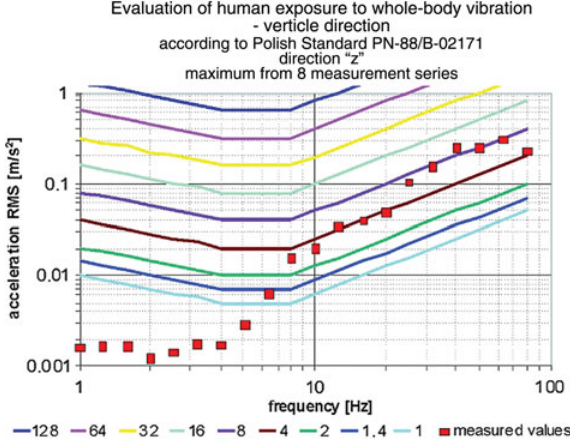
Fig. 13. RMS of acceleration (cid:2) 1/3 octave analysis on the background of human sensitive